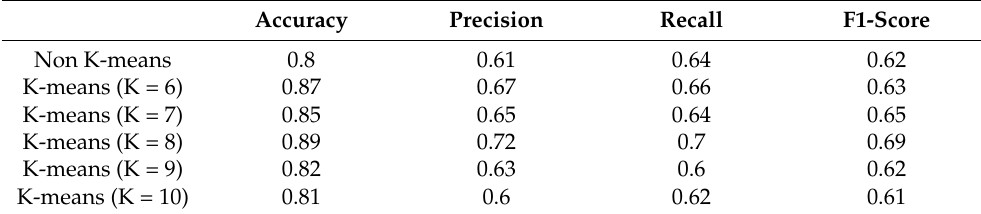
Table 5. Comparison of the accuracy before and after K-means.